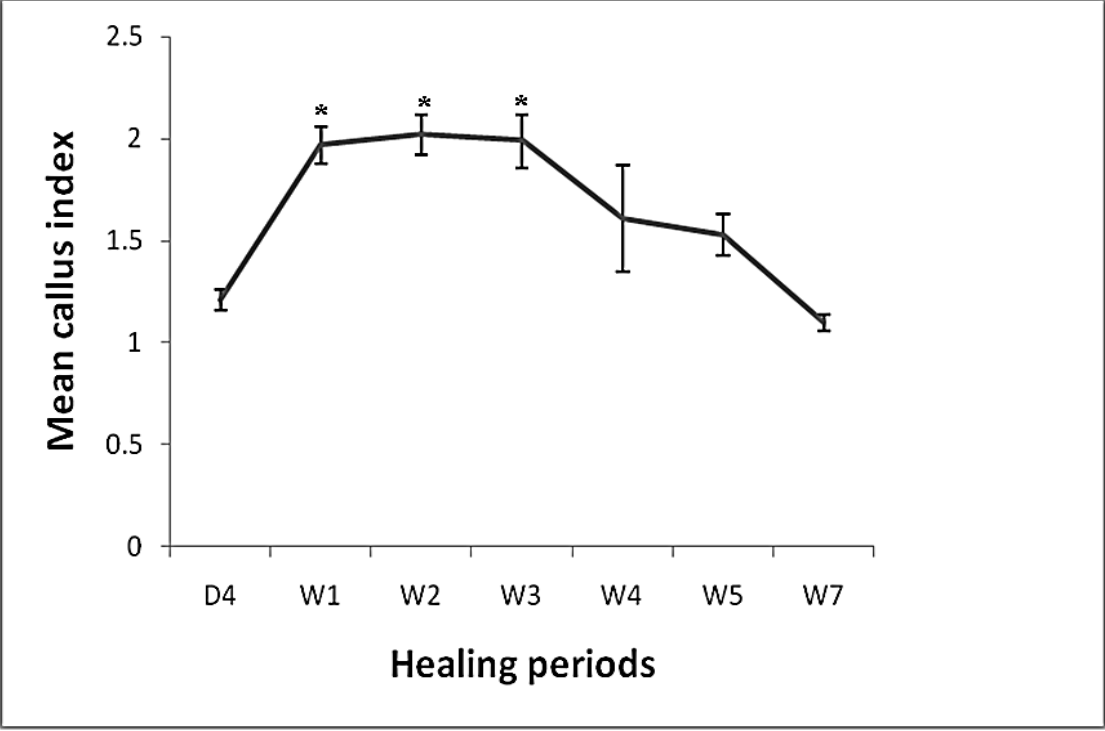
Figure 7. Graphical presentation of fracture consolidation recorded evidence by the trend of callus formation and resorption in the course of the fracture healing. *Denotes significant difference ( P < 0.05, one-way ANOVA) from D4 among the mean callus index at different healing intervals. Data were presented as Means ± SEM.